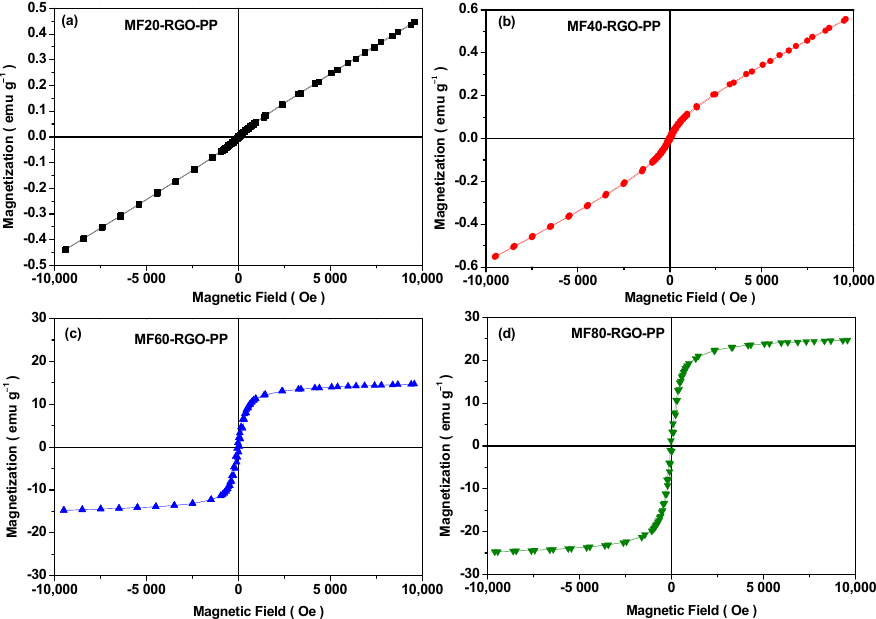
Figure 10. Magnetic hysteresis curves of prepared nanocomposites MF20-RGO-PP, MF40-RGO-PP, MF60-RGO-PP and MF80-RGO-PP samples.